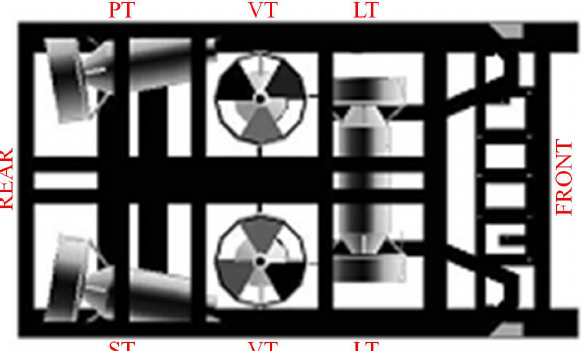
Figure 19: Thruster installation configurtion (top view). Legend: L = Lateral, P = Port, S = Starboard, T = Thruster, and V = Vertical.